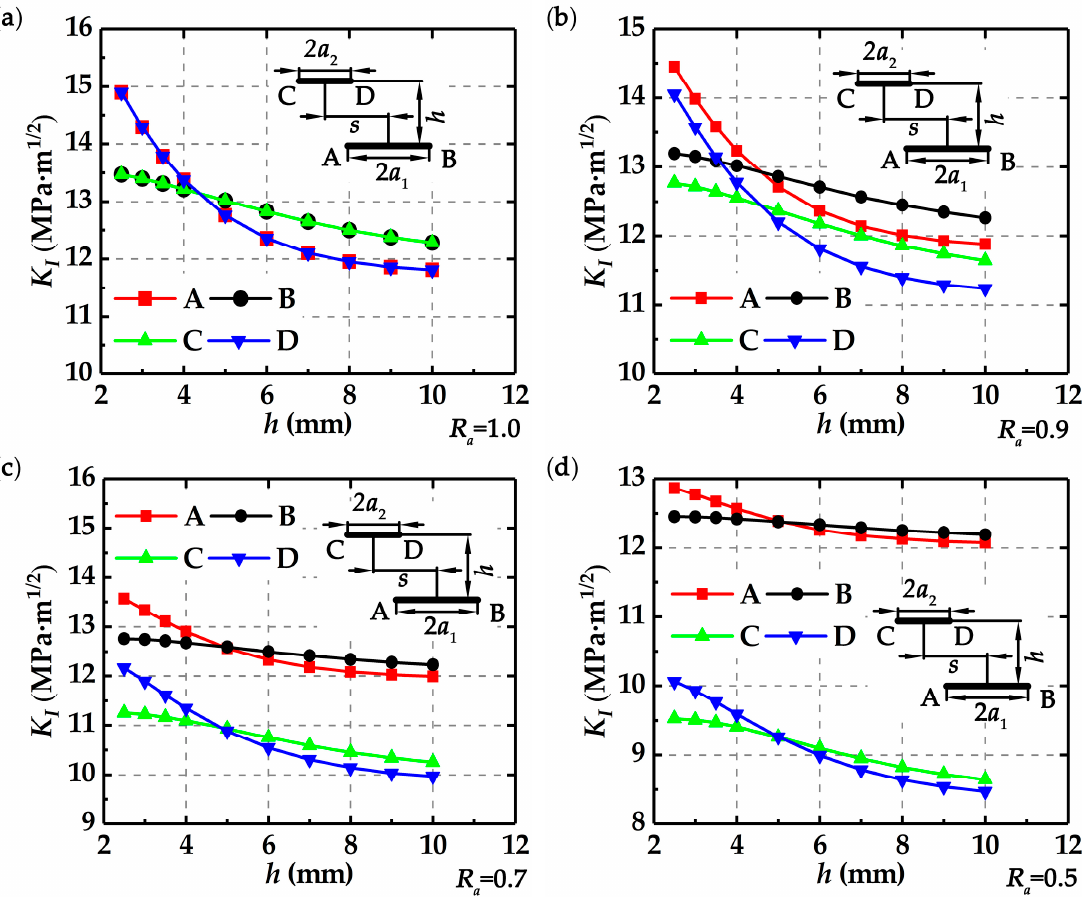
Figure 5. Changes of K I with h at s = 7 mm for different R a : ( a ) R a = 1.0, ( b ) R a = 0.9, ( c ) R a = 0.7, and ( d ) R a = 0.5.